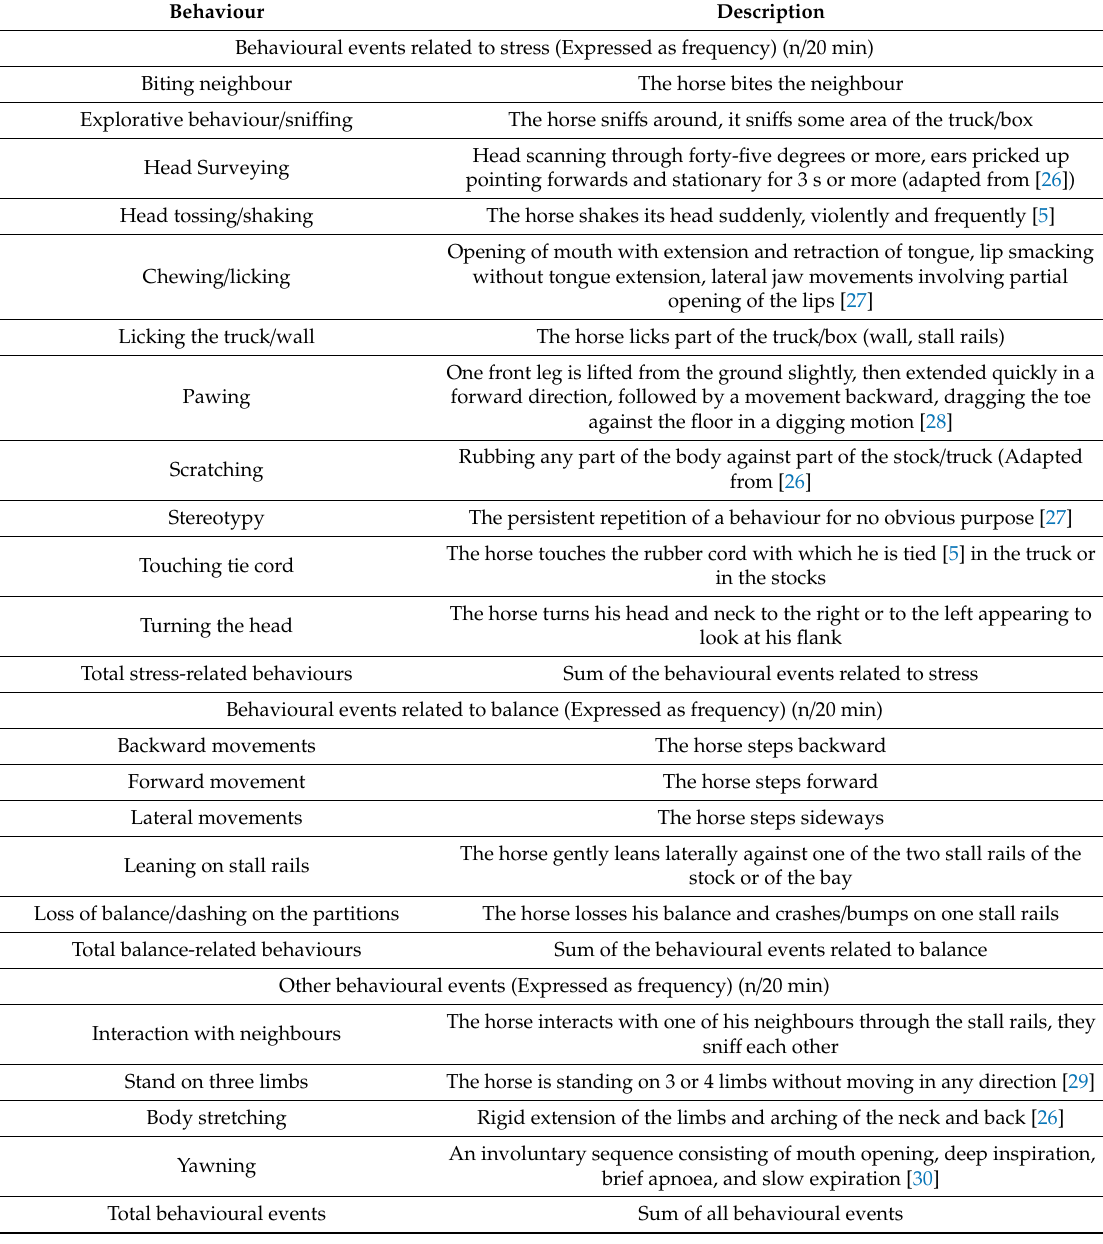
Table 1. Behaviour sampling ethogram used to measure the frequency of selected behavioural events during confinement or transportation. Total stress-related behaviour was calculated summing the frequency of all behavioural events related to stress. Total balance behaviour was calculated summing the frequency of all behavioural events related to balance. Total behavioural events were calculated summing the frequency of all the single behavioural